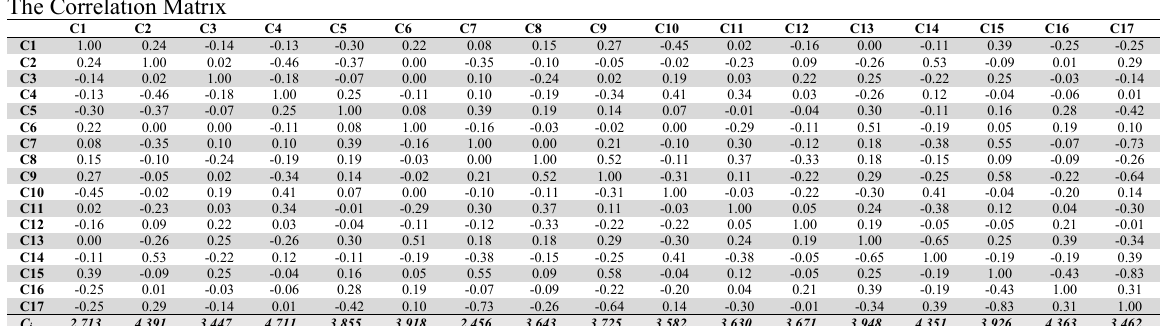
The Correlation Matrix C1